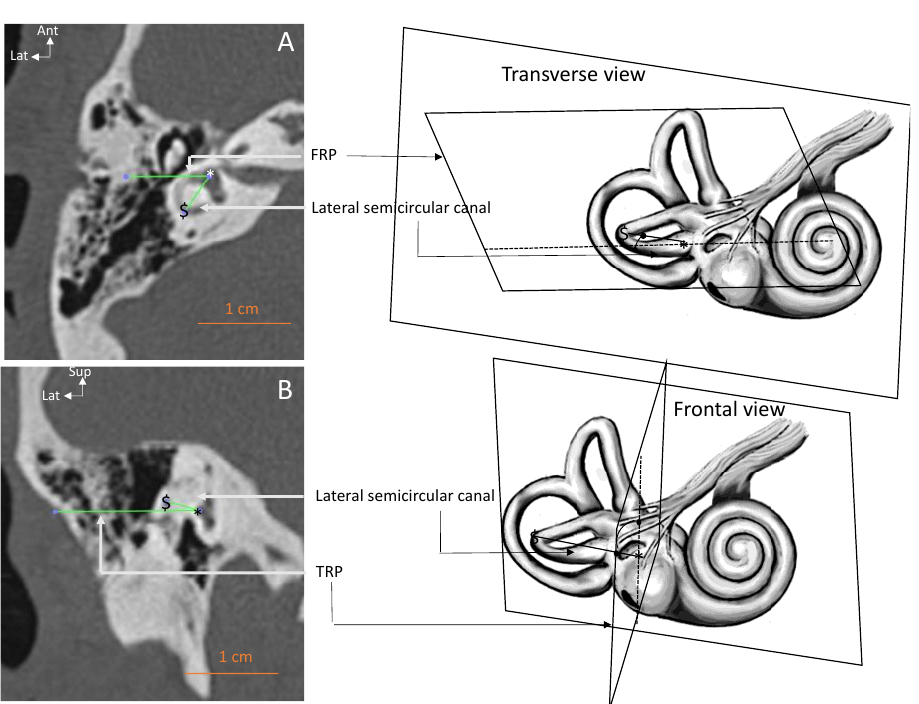
Figure 2. Angle measurements for the lateral semicircular canal (SCC) in the transverse ( A ) and frontal ( B ) views. Angles are measured between a line passing between the canal apex and the center of its ampulla (*) and its projection on each plane ($). FRP: frontal reference plane. TRP: transverse reference plane.